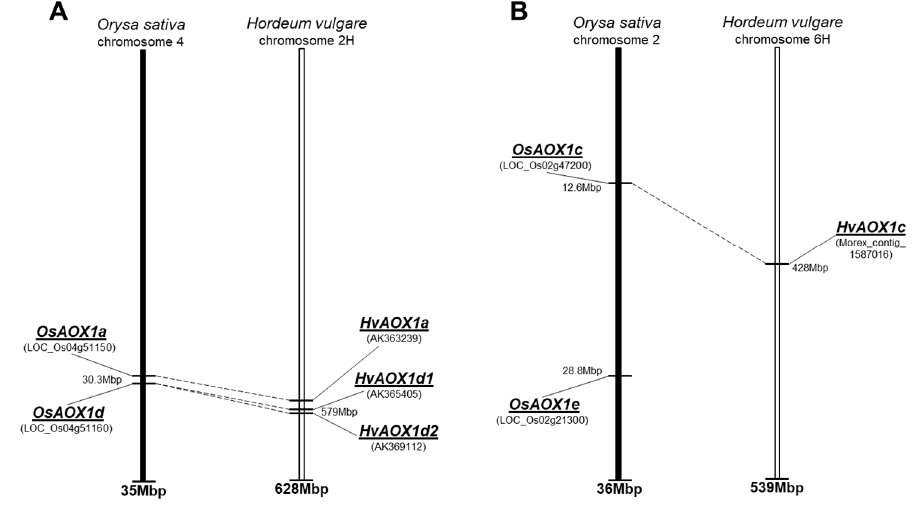
Figure 1. Rice and barley comparative maps with positions of identified AOX genes. ( A ) AOX1a and AOX1d ; ( B ) AOX1c and AOX1e . Corresponding genes are indicated by dashed lines. Information about rice and barley genes are their locations was extracted from web-sites, respectively: